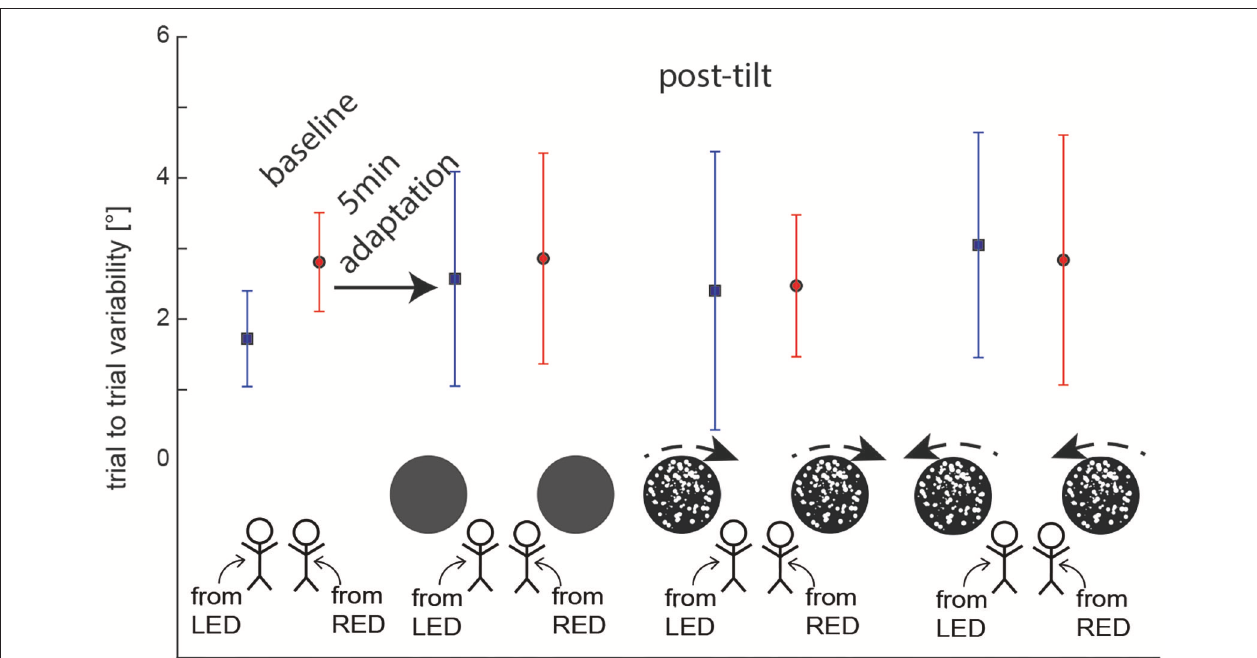
FIGURE 4 | Overall average ( ± 1 SD) trial-to-trial variability of turntable adjustments are shown for both baseline and post-tilt conditions. For the post-tilt trials the specific adaptation condition (either 90 ◦ left-ear down (LED, lines in blue) or 90 ◦ right-ear-down (RED, lines in red) and the visual background (no optokinetic stimulus, optokinetic CW, optokinetic CCW) is illustrated. Note that in the post-tilt period all trials were collected in darkness, i.e., no optokinetic stimuli were